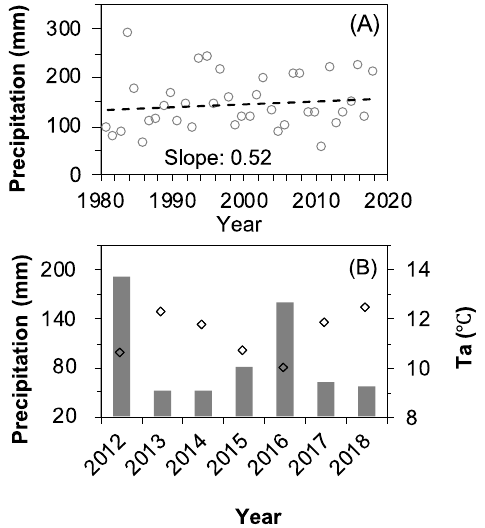
Figure 2. Variations in annual precipitation ( A ) and accumulated precipitation (bar) and average air temperature (diamond) from 1 January to 31 August over the period of 2012–2018 ( B ).